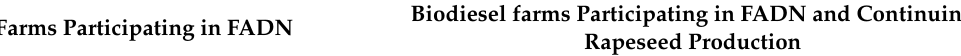
Table 4. Total assets (PLN), including fixed-base and chain-linked indices of changes in the value of total assets, in biodiesel farms participating in the